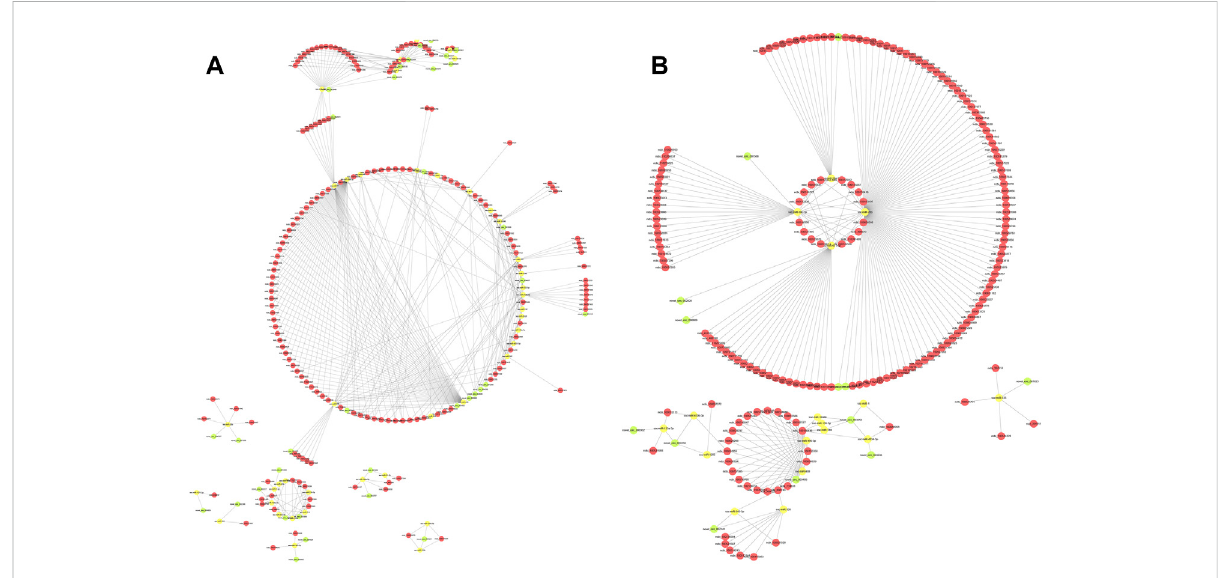
FIGURE 6 The circRNA-miRNA-mRNA interaction network. (A) The circRNA-miRNA-mRNA interaction network between TN and TL. (B) The circRNA- miRNA-mRNAinteractionnetwork between LNandLL.Greencirclesrepresent circRNAs,yellowcirclesrepresentmiRNAs,andredcirclesrepresent